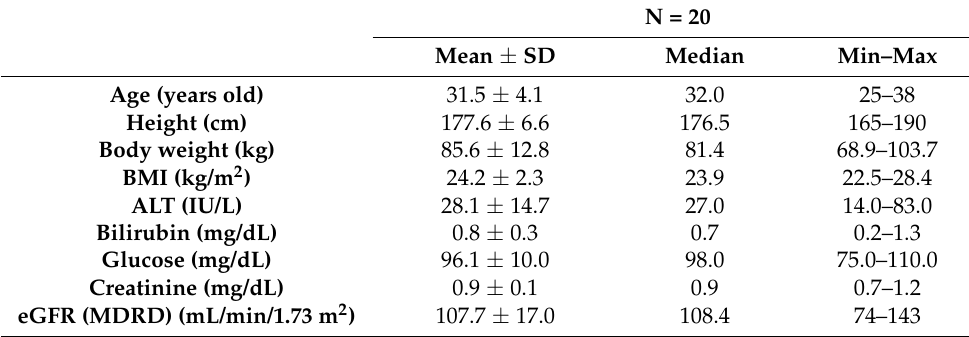
Table 1. Demographic and medical characteristics of experimental